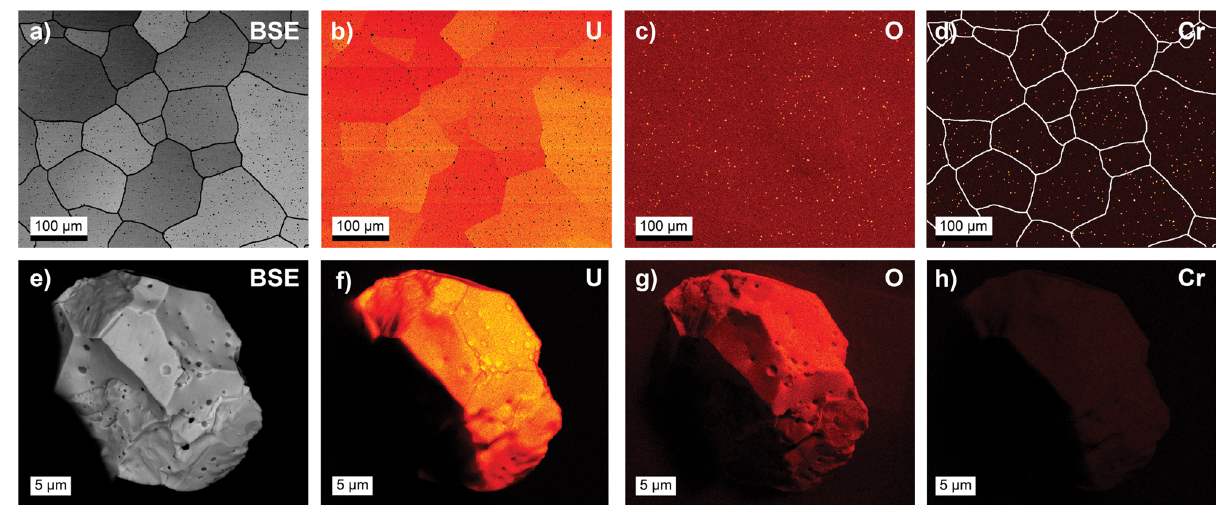
Fig. 1 | Electron micrographs of bulk Cr-doped UO 2 and a single crystal extracted from the parent material. BSE ( a , e ) and EDS ( b – d , f – h ) U-L, O-K and Cr-K edge images of Cr-doped UO 2 pellet (top) with 3500ppm addition as Cr 2 O 3 shown comparatively with a single crystal grain (bottom) extracted from the same material. The grain boundary map of the BSE Cr-doped UO 2 pellet has been superimposed on the Cr-K edge EDS map to highlight the distribution of Cr –